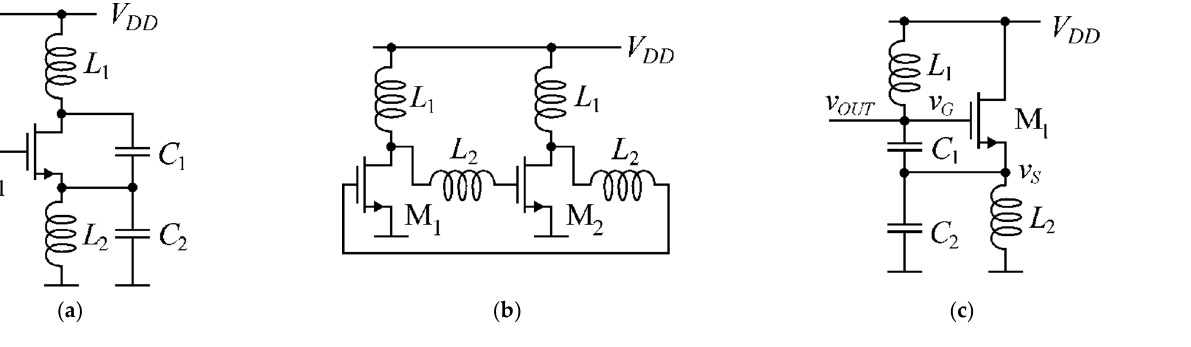
Figure 1. Ultra ‐ low ‐ voltage oscillators: ( a ) ESCO; ( b ) ESILRO; ( c ) proposed HSCO. Figure 1. Ultra-low-voltage oscillators: ( a ) ESCO; ( b ) ESILRO; ( c ) proposed